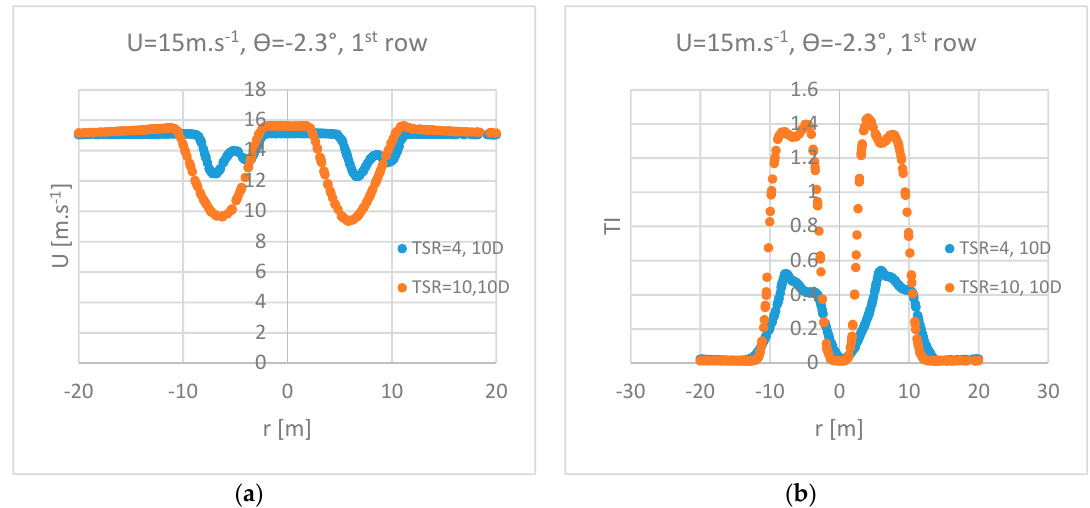
Figure 9. ( a ) Axial velocity profile at 10D (diameters) downstream the rotor in the wake of the first row; and ( b ) TI profile at 10D (diameters) downstream the rotor in the wake of the first row. Different line colors represent the TSR (or λ ) of 4 (blue) or 10 (orange).